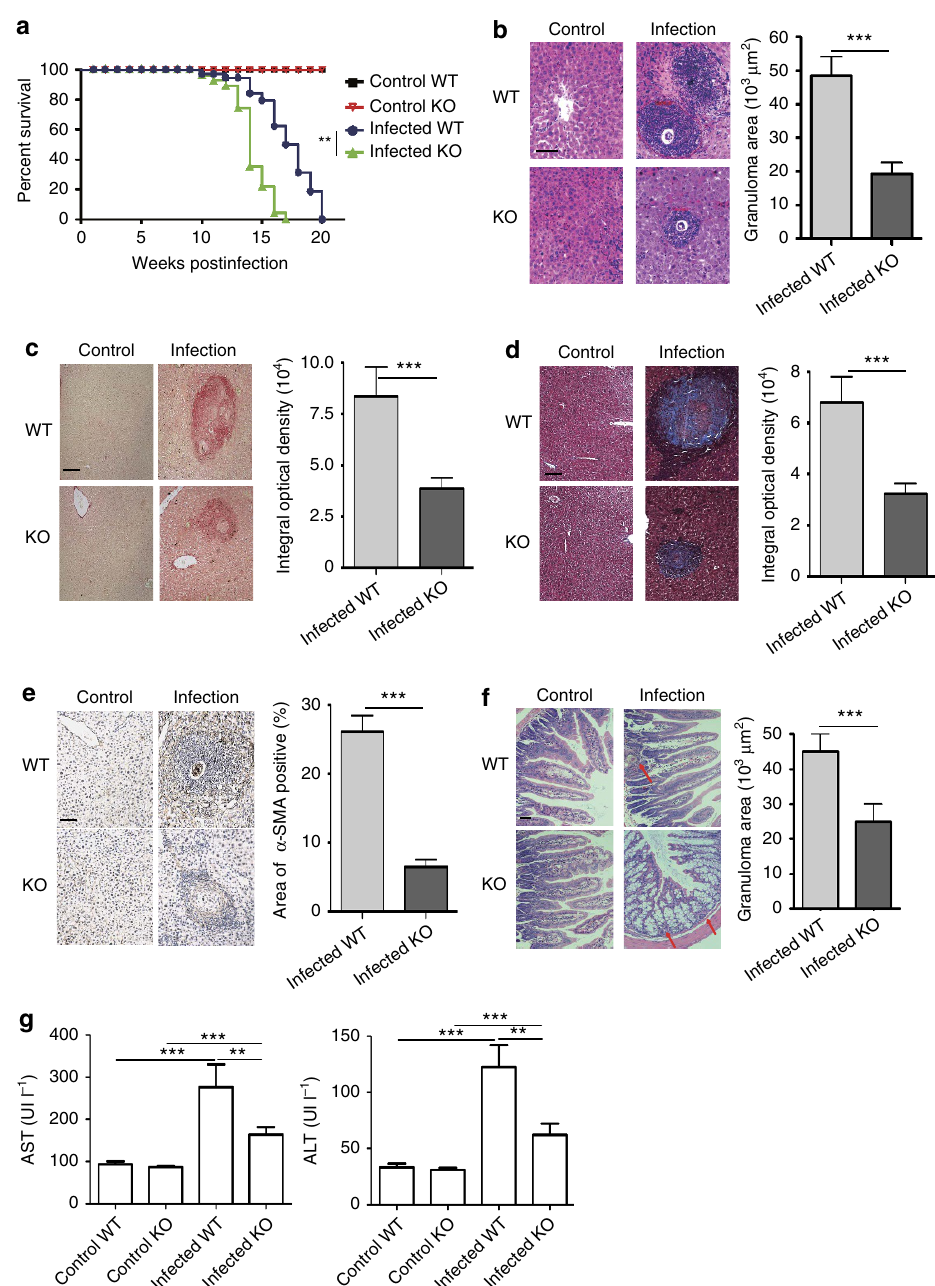
Figure 1 | SR-A deficiency alleviates survival and pathology after S. japonicum infection. ( a ) Survivals within 20 weeks post infection were calculated using Kaplan–Meier survival curves with log-rank test and w 2 statistical analysis, data are expressed as the mean ± s.d. of 24 mice from two independent experiments. ( b , f ) Paraffin-embedded liver sections stained with H&E. Scale bars, 100 m m. For each mouse, the sizes of 30 liver granulomas ( b ) or 10 intestine granulomas ( f ) around single eggs were quantified with AxioVision Rel 4.7. Paraffin-embedded sections were stained with sirius red ( c ), Masson ( d ) or a -SMA ( e ). Scale bars, 100 m m; The mean optical density of collagen fibres by sirius red, Masson or a -SMA staining was digitized and analysed by using Image-Pro Plus software. ( g ) Levels of serum ALT/AST were determined. Data are expressed as the mean ± s.d. of 12 mice for each group in one representative experiment. All experiments were repeated twice ( f ) or three times ( b – e , g ) with similar results, *** P o 0.001, ** P o 0.01, * P o 0.05 (Student’s t -test ( b – f ) or ANOVA/LSD ( g MHC II and costimulatory molecules, including CD80 and CD86 CD4 þ T-cell differentiation, peritoneal macrophages were after SEA stimulation (Supplementary Fig. 3b). purified from S. japonicum -infected WT or SR-A-deficient mice Taken together, these results suggest that SR-A deficiency leads (M2 or M1 dominate, respectively, Supplementary Fig. 4a) to a skewed M1-polarized phenotype of macrophages. and adoptively transferred into normal WT mice. Results showed that the adoptive transfer of macrophages from infected SR-A-deficient mice with an M1-polarized phenotype SR-A drives M2 and favours Th2 polarization . To investigate (Supplementary Fig. 4a) resulted in significantly higher Th1 the contribution of SR-A and macrophage polarization to